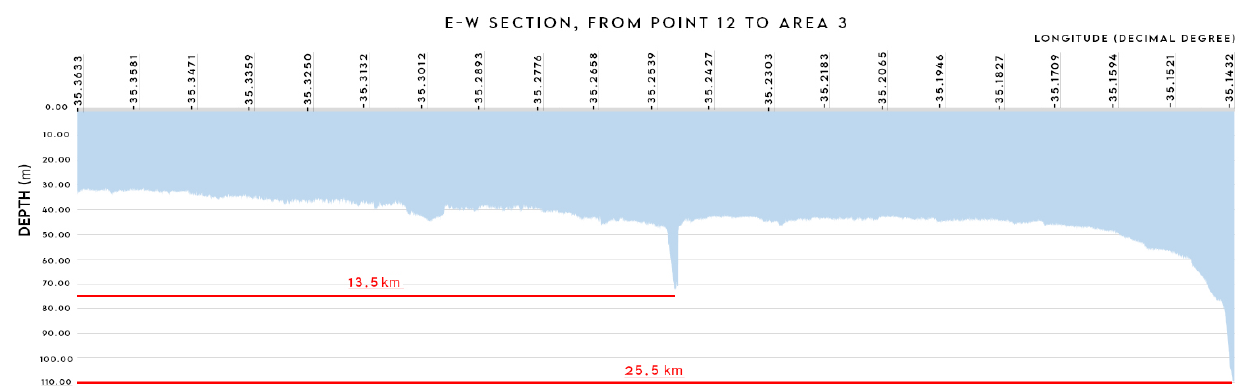
Figure 4. Digital elevation model (DEM) for area 2 with hillshade interpretation highlighting several features, such as the reef top, channels, and isolated head or pinnacle. Red square represents area 2.